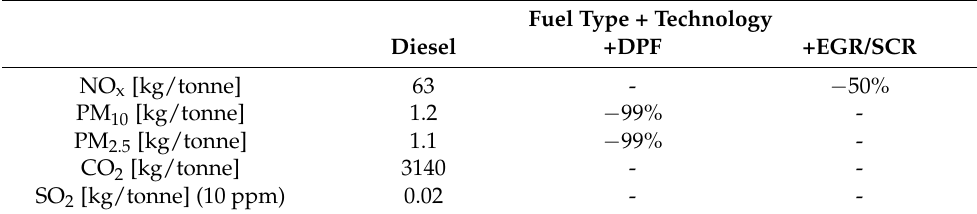
Table 7. Emission factors and emission abatement technologies for